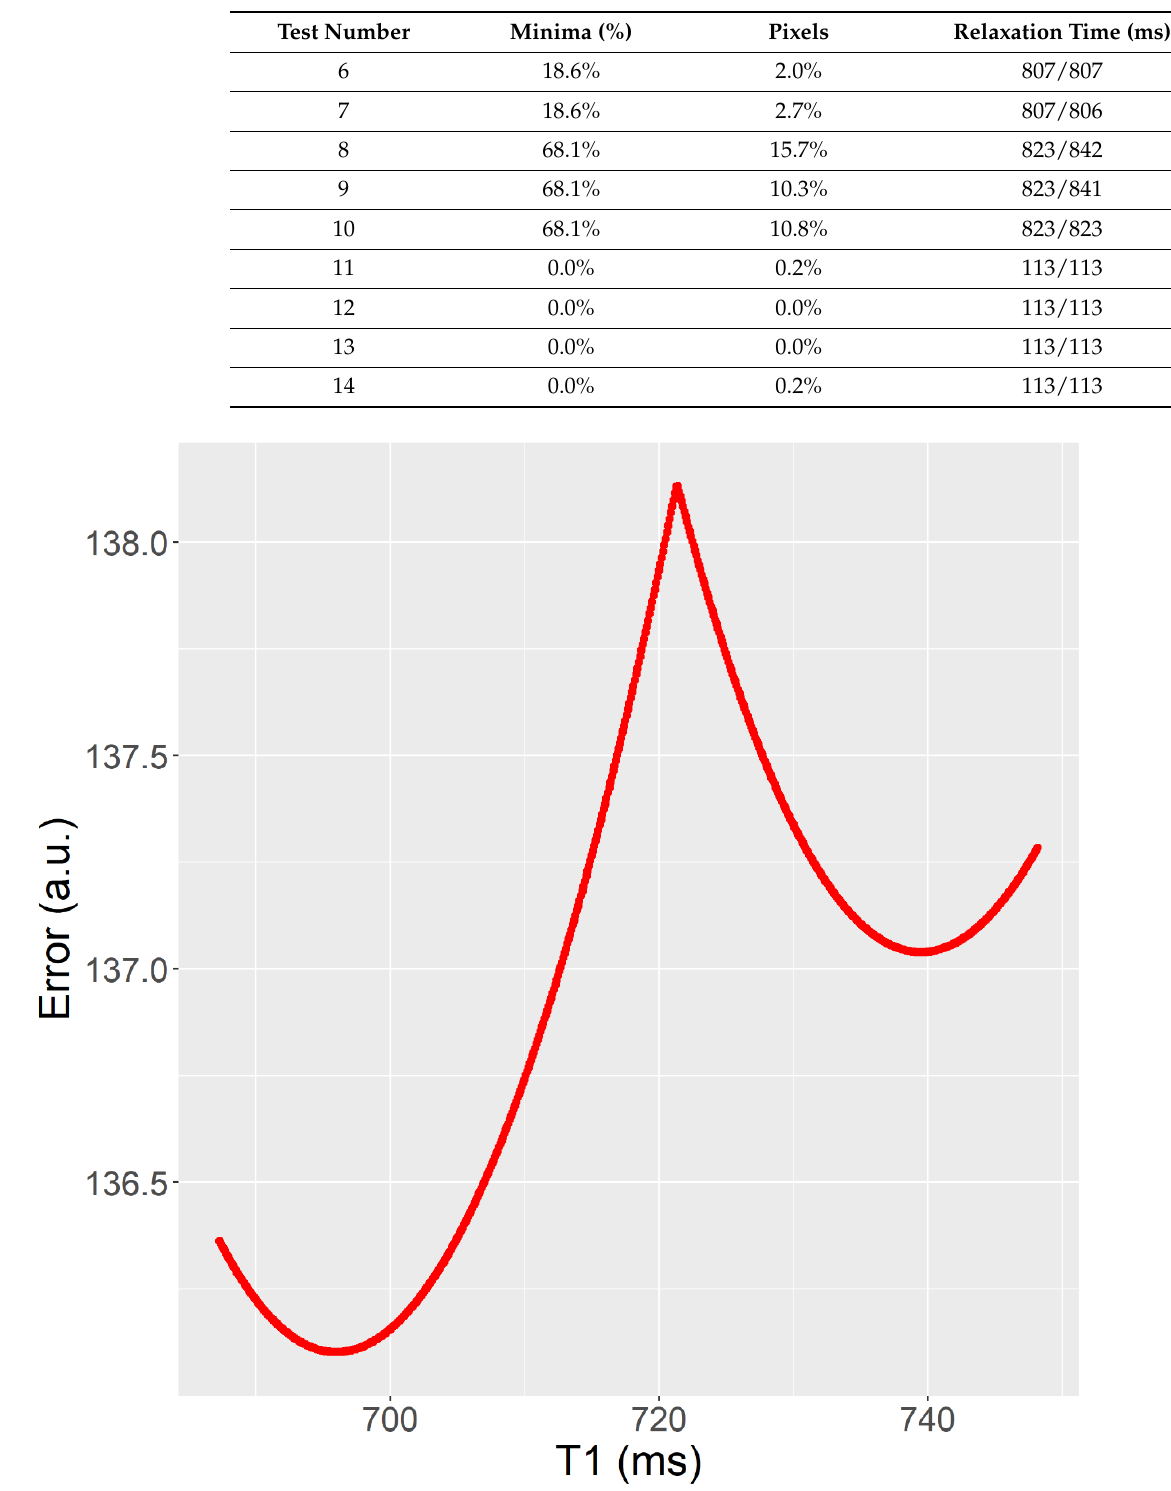
Figure 3. Fitting error (y) as a T 1 (x) function after parameters A and B have been fitted. The T 1 value obtained in fit (RD-NLS) was T 1 = 696 ms, whereas the T 1 value obtained in fit b (Matlab, Levenberg-Marquardt) was T 1 = 740 ms. It corresponds to Test 2 (mouse data).